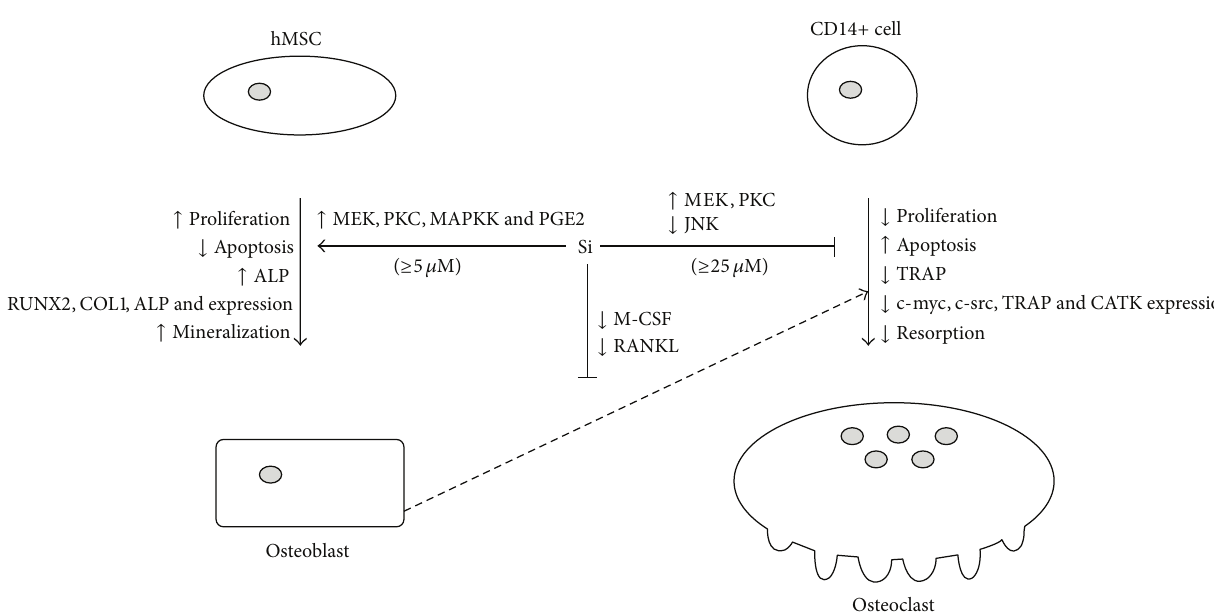
Figure 6: Effects of Si on human osteogenesis and osteoclastogenesis and proposed